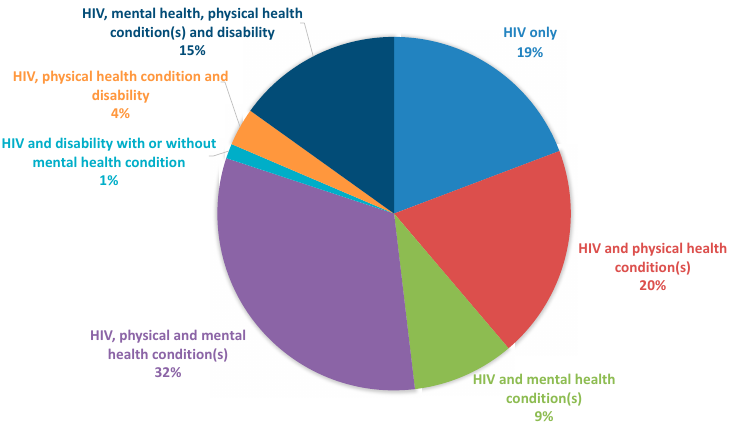
Figure 2. Overlapping burden of physical, mental health and disability conditions in participants from the Canadian HIV Women’s Sexual and Reproductive Health Cohort Study (CHIWOS, n = 1039).